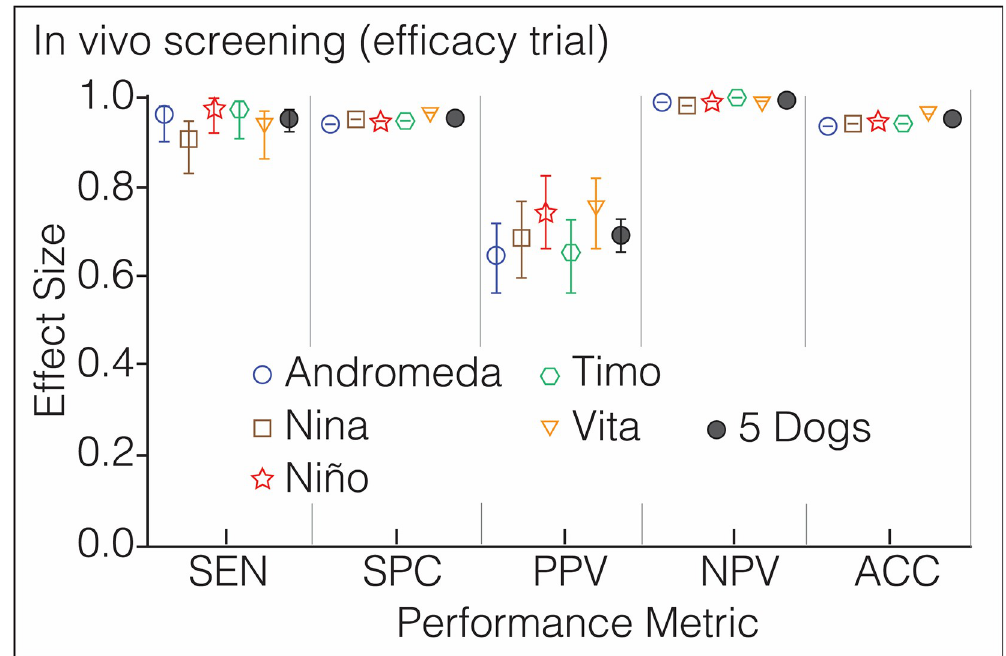
Fig 5. Phase 3: In vivo screening (efficacy trial). Performance metrics of 5 dogs screening for COVID-19 the patients and staff of Hospital Universitario San Vicente Fundación and the personnel working in the Office of the Governor of Antioquia; n = 848, global prevalence = 10.5%. Each symbol has a different color to ease visualization of the dogs. The vertical lines above and below the symbols represent the 95% confidence interval for each metric, which is contained within the symbol for SPC , NPV and ACC . Additional numeric data in S4 Table in S1